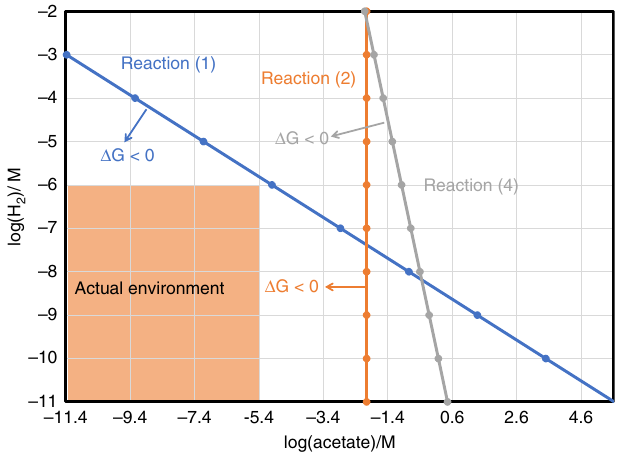
Fig. 5 Thermodynamic constraints on anaerobic benzoate and hexadecane degradation. Three reactions (Reactions 1, 2, and 4) are illustrated as taken from Table 2 where Δ G> 0. Thermodynamics for each reaction are indicated by a line in its corresponding color. If Δ G < 0, the reaction is energetically favorable (indicated by arrow), and if Δ G > 0 the reaction is assumed not to occur. In the studied environment (outlined in the shaded area), hydrogen concentrations fall below 1 µ M while acetate concentrations are below 2.5 µ M. The graph shows that Δ G for three reactions are all negative when both actual concentrations of acetate and hydrogen are taken into